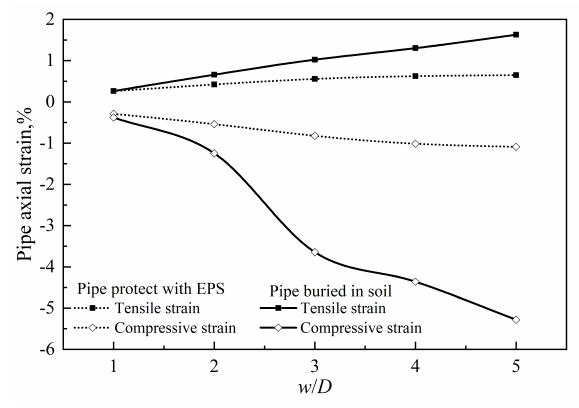
Fig. 4. Max tensile and compressive strain of buried pipe with different w /